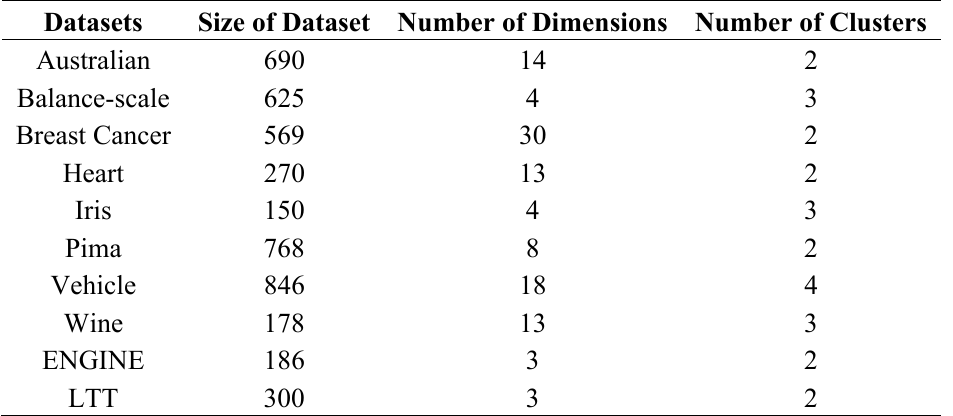
Table 2. Summary of 10